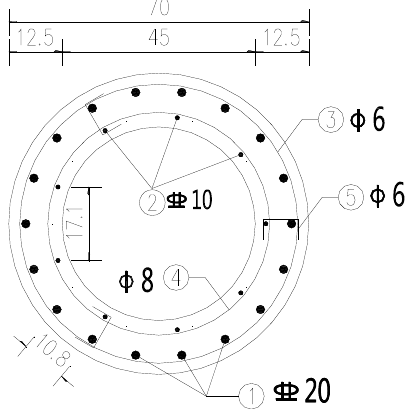
diagram of the scaled pier column is shown in Figure 6.